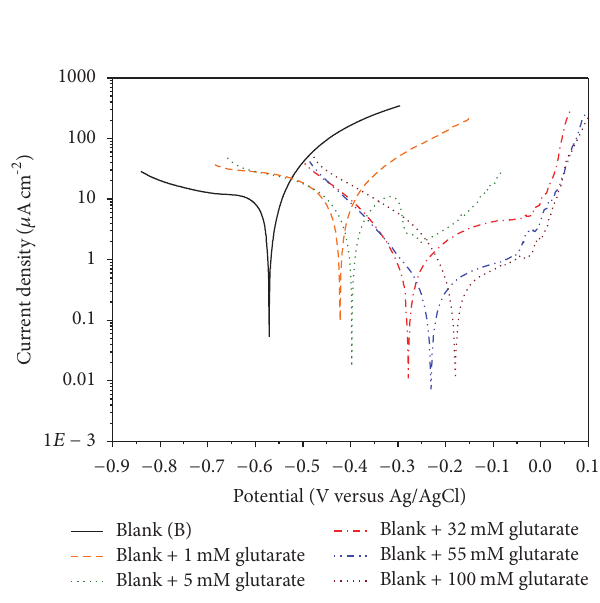
Figure 6: Typical polarization curves of carbon steel in 0.02 M NaCl solution in the absence (blank) and in the presence of different concentrations of sodium glutarate.